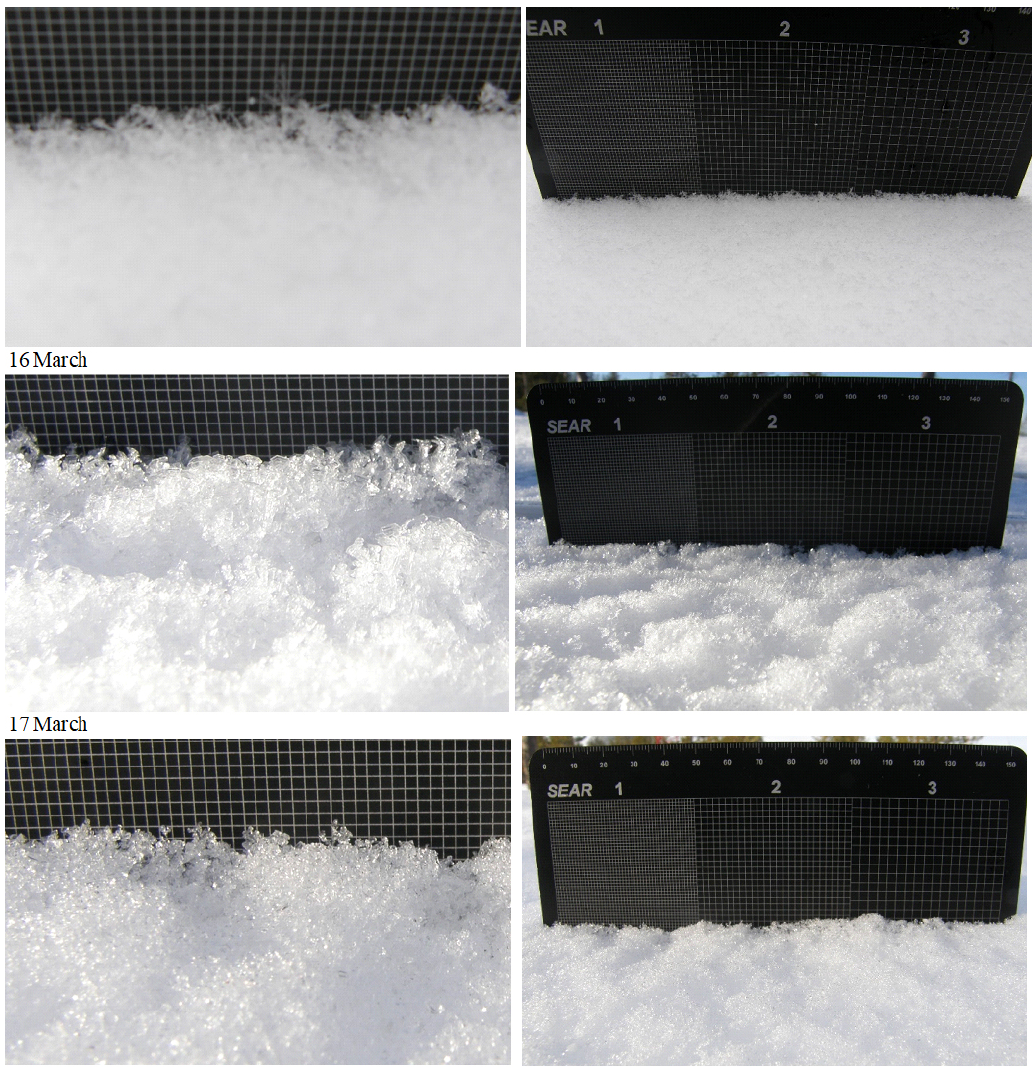
Figure 19. Microscale snow surface structure evolution during 16–18 March 2009. In the left images the scale of the grid is 1mm. In the right images the grids correspond to 1, 2 and 3mm from left to right.